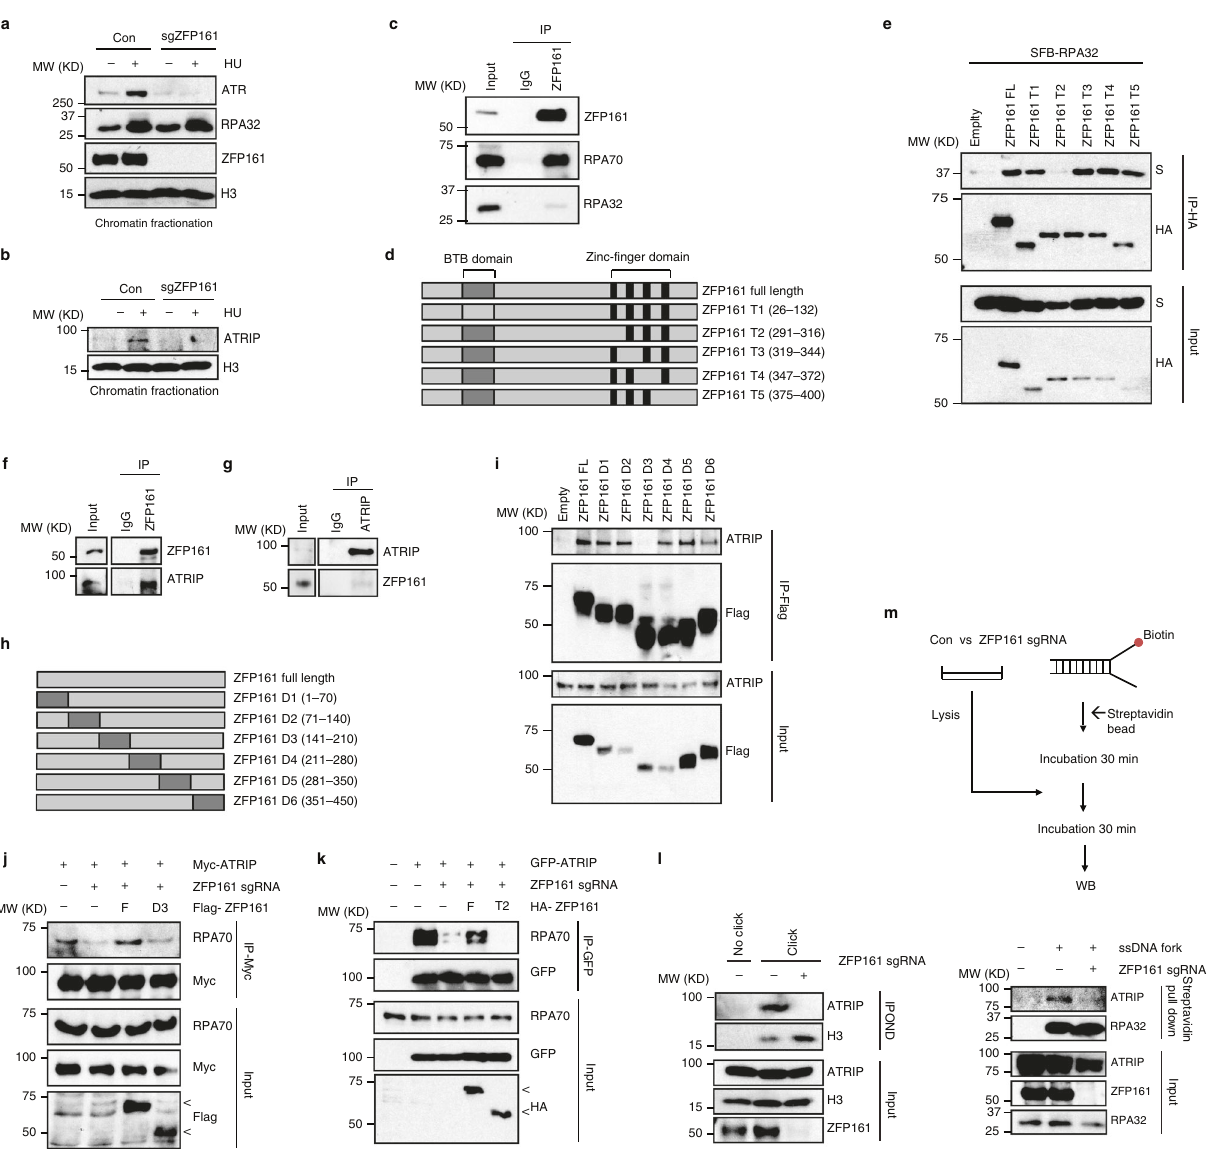
Fig. 4 ZFP161 mediates the RPA-ATRIP interaction. a , b Chromatin fractionations from HCT116 cells in presence or absence of ZFP161 following 10 mM HU treatment for 2 h were used for immunoblotting with indicated antibodies. c Whole cell lysates from HCT116 cells were used for immunoprecipitation with ZFP161 antibody. d The schema of ZFP161 constructs used to identify the minimal region required for its interaction with RPA32. e HEK293T cells were transfected with S-tagged RPA32 and ZFP161 vectors. After 48 h, the interaction between ZFP161 and RPA32 was determined by immunoprecipitation and immunoblotting with indicated antibodies. f , g Whole cell lysates from HCT116 cells were used for immunoprecipitation with ZFP161 ( f ), or ATRIP ( g ) antibodies. h The schema of ZFP161 constructs used to identify the minimal region required for its interaction with ATRIP. i HEK293T cells were transfected with the indicated ZFP161 vectors. Aftter 48 h, ZFP161 and ATRIP interaction was determined by immunoprecipitation and immunoblotting with indicated antibodies. j , k HCT116 cells expressing or lacking ZFP161 were transfected with constructs encoding Myc-ATRIP, ZFP161 (WT) and D3 mutant ( j ) or T2 mutant ( k ). Whole cell lysates were immunoprecipitated with Myc antibody and immunoblotted with indicated antibodies. l ZFP161 de fi cient HCT116 cells were incubated with EdU and HU. Replication fork proteins were isolated by iPOND and immunoblotted with indicated antibodies. m Biotin labeled single fork DNA was incubated with HCT116 whole cell lysates and pulled down with streptavidin beads. The interaction of ATRIP and RPA on DNA was determined by immunoblotting. < : ZPF161 full length and mutants bands. Source data are provided as a Source Data fi